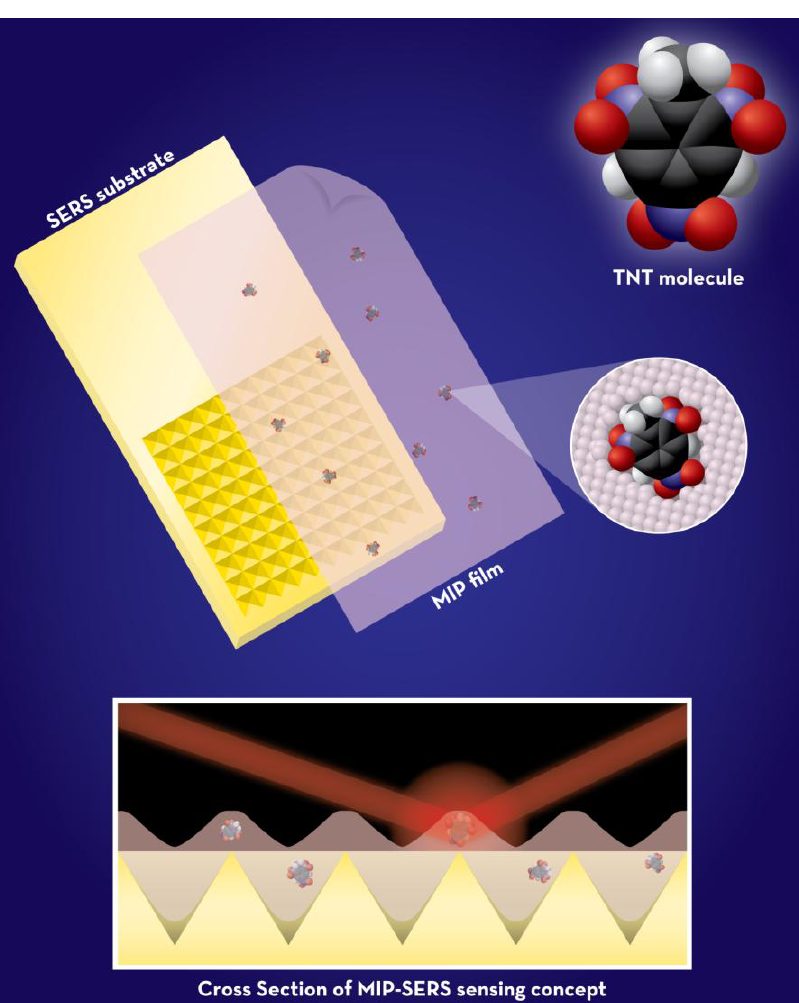
Figure 1. MIP-SERS detection